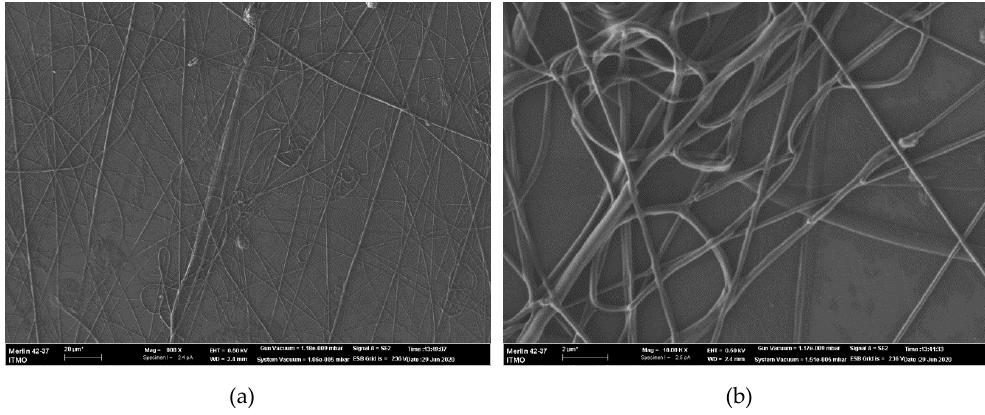
Figure 5. SEM images of curcumin/usnic acid-loaded hyaluronic acid fibers electrospun from the polymer solutions under 22 kV: ( a ) magnification 1000 × ; ( b ) magnification 10,000 × .